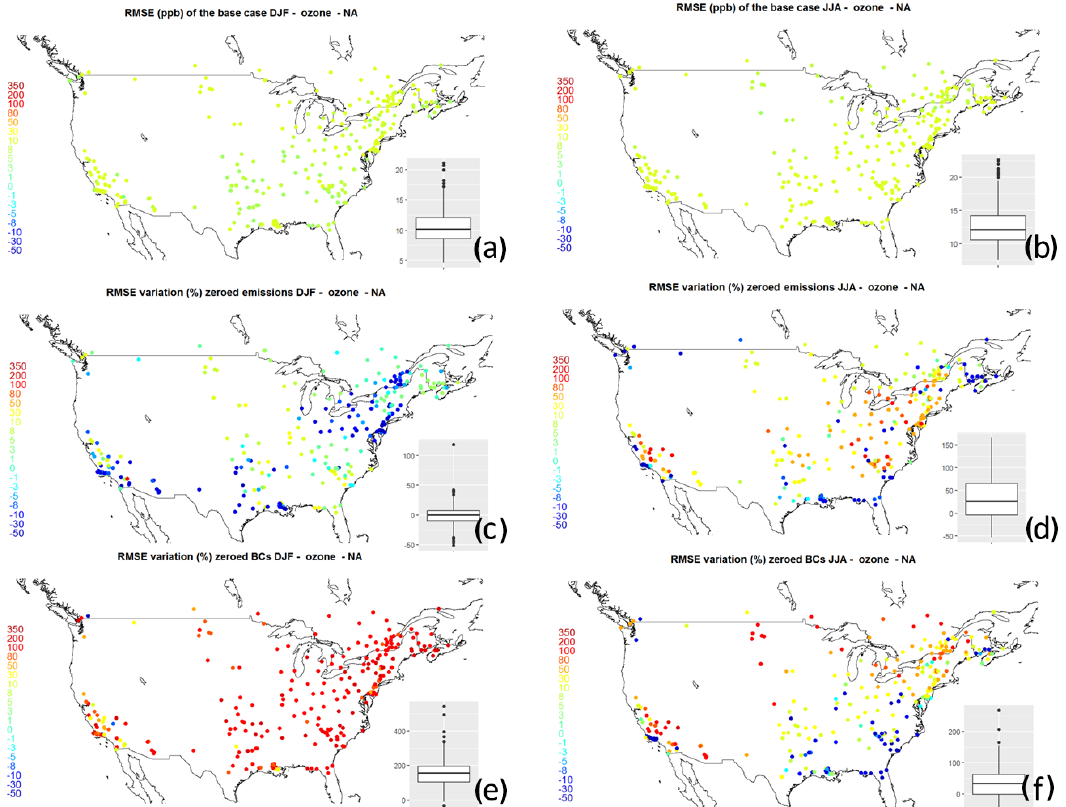
Figure 16. (a, b) Spatial maps of RMSE (in ppb) for the base case. (c, d) Percentage RMSE changes for the zeroed emissions case with respect to the base case. (e, f) Percentage RMSE changes for the zeroed boundary condition case with respect to the base case. (a, c, e) Winter months (DJF); (b, d, f) summer months